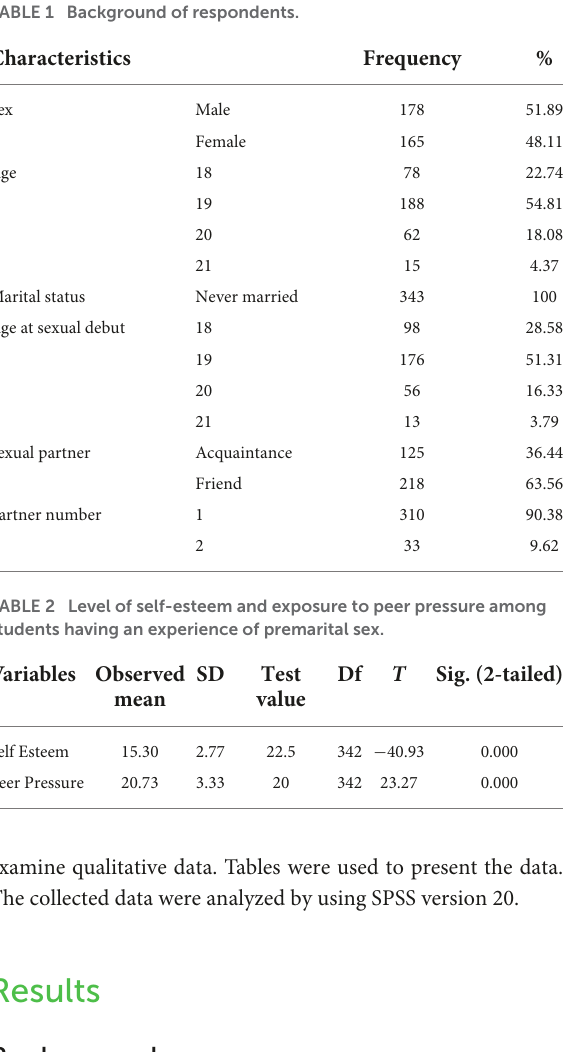
TABLE 1 Background of respondents.